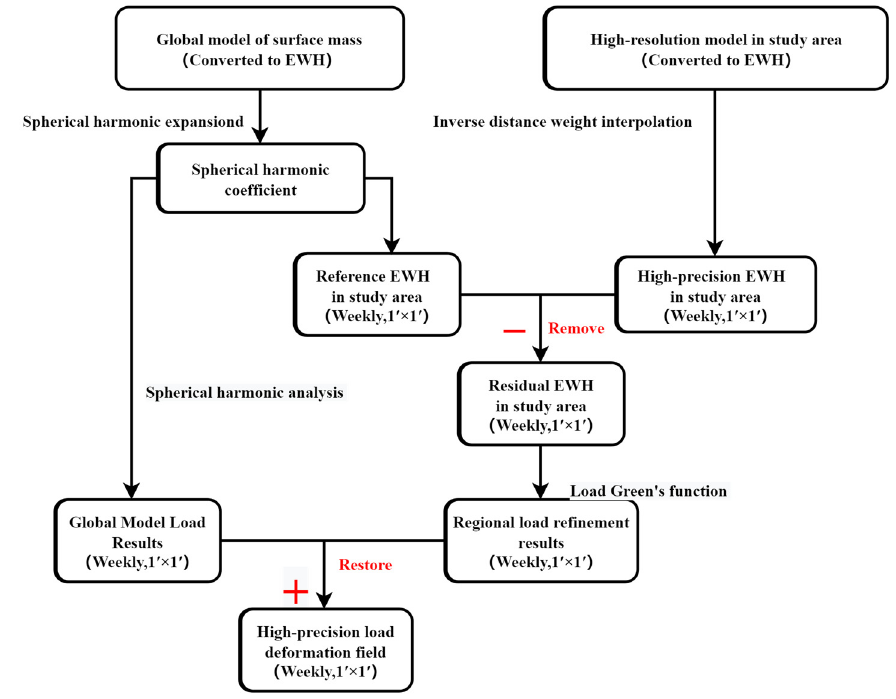
Figure 2. Flowchart of the high-precision load deformation field solution.